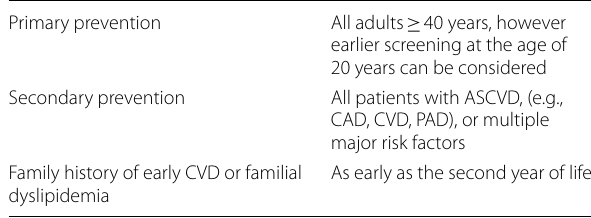
Table 4 Recommendations for screening [18] Primary